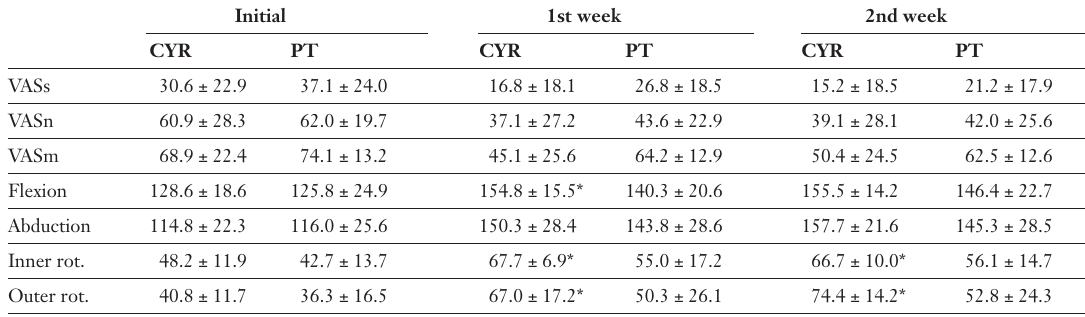
Comparison of the early response to two methods of rehabilitation in adhesive capsulitis